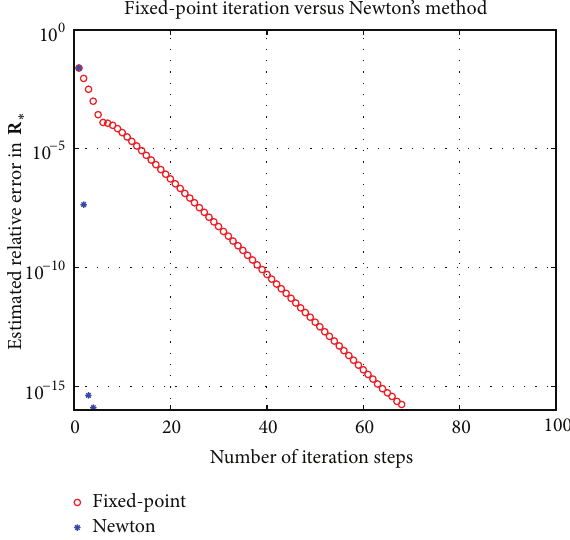
Figure 11: Output from the program demo9.m . The fixed-point iteration (36) and (37) is compared to Newton’s method for (38).